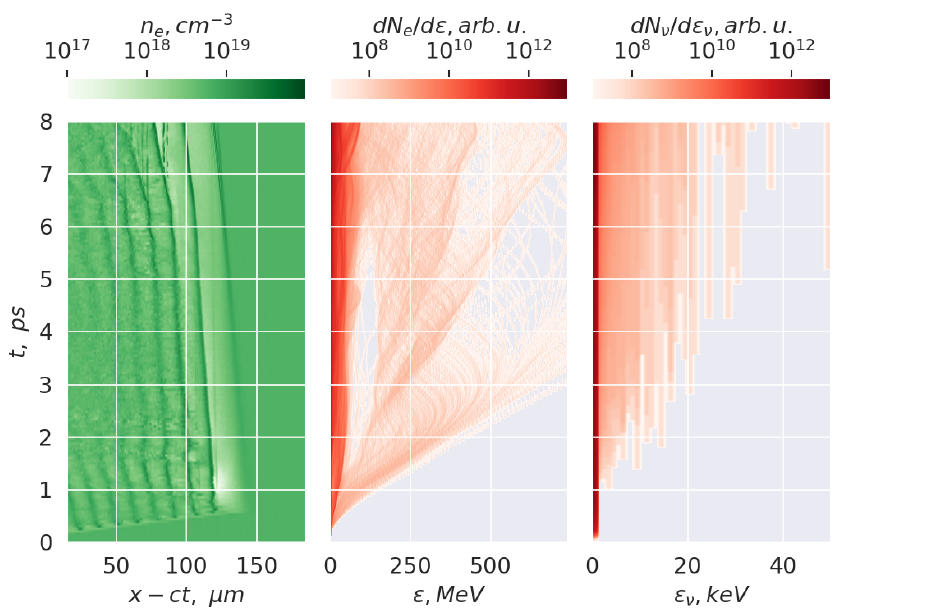
Figure 3. Simulation results for a Gaussian laser pulse with a duration of 50 fs. The data shown are similar to those in Figure 2. Note, however, that there are different scales for energies.